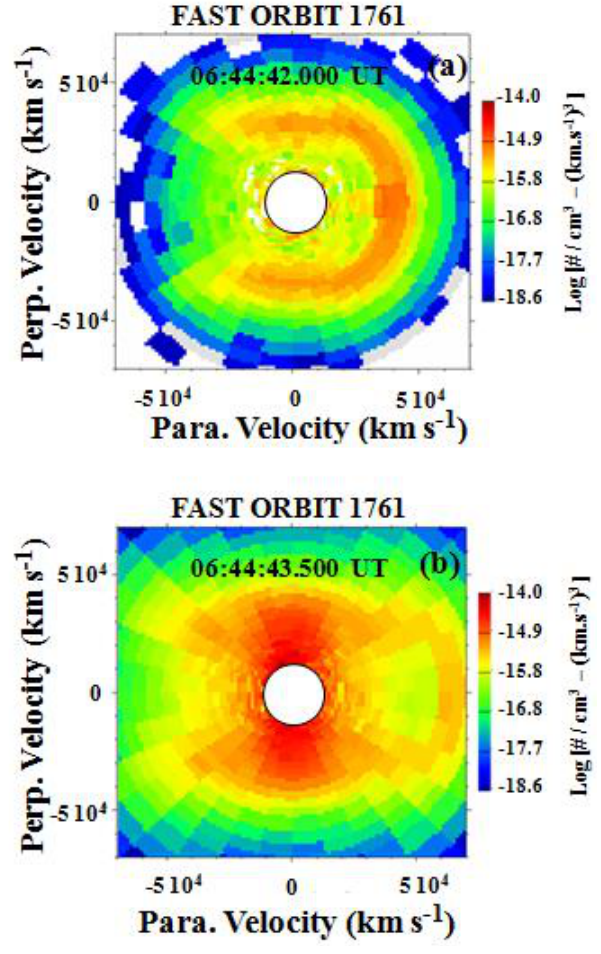
Figure 6. A typical full ring horseshoe distribution of electrons measured inside the density cavity at 06:44:42UT is shown in (a) , while an incomplete horseshoe electron distribution exhibiting a pronounced beam-like character is recorded in the enhanced den- sity region around 06:44:43.500UT as illustrated in (b) . The dis- tributions are plotted in perpendicular, parallel velocity space. Both distributions are averaged over ∼ 0.8s and the low-energy electron background has been eliminated in order to remove